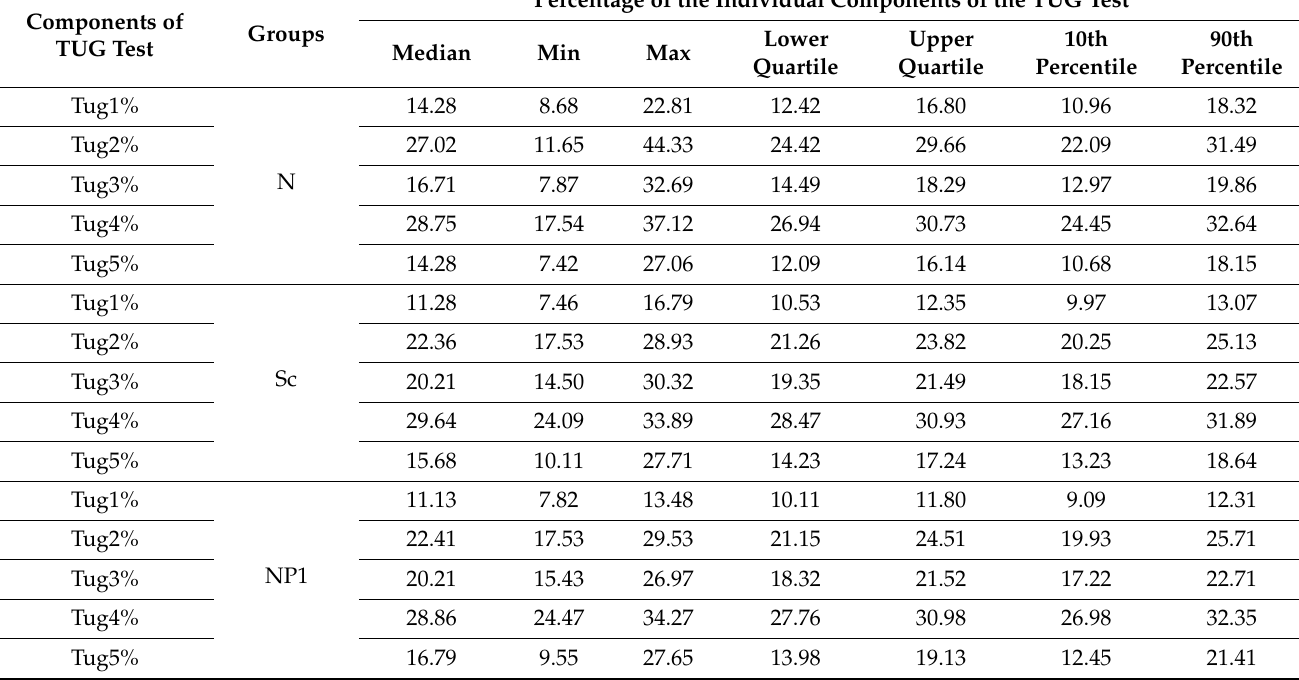
Table 3. Percentage share in the individual components of the TUG test among the studied